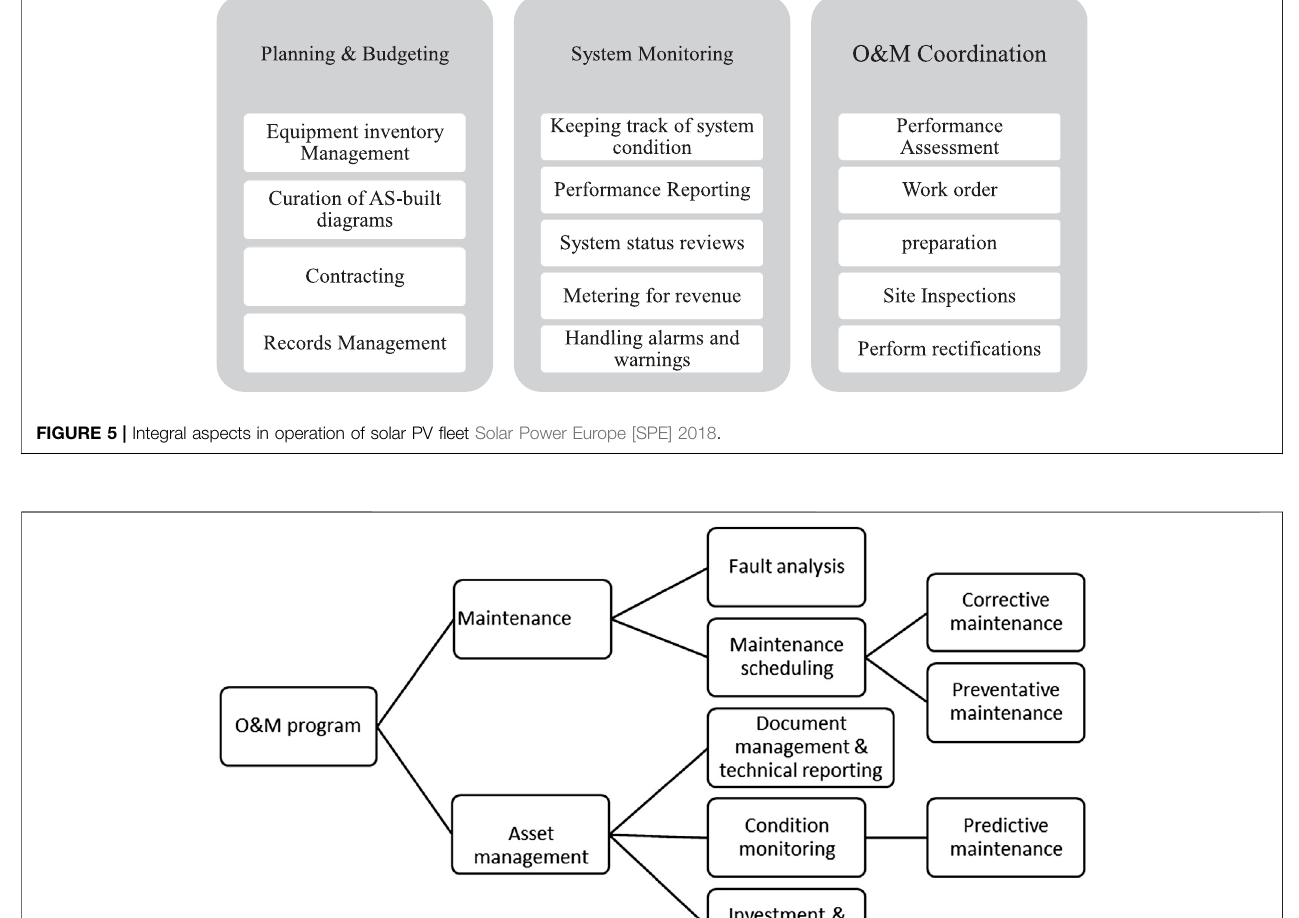
Frontiers in Energy Research |